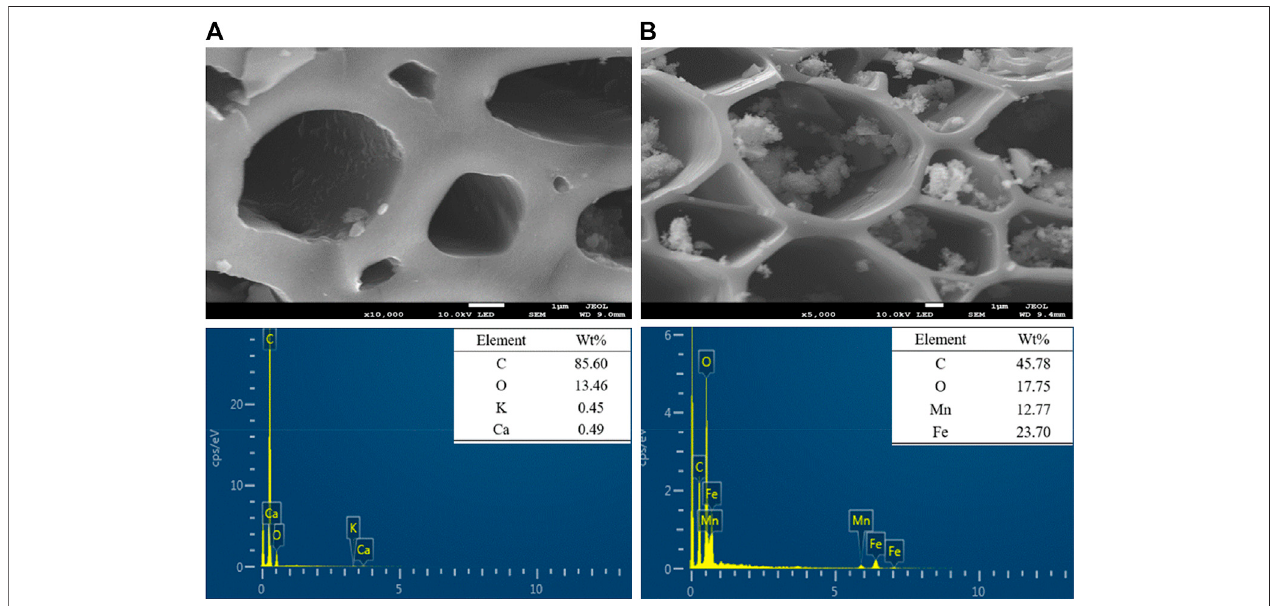
FIGURE 2 | Surface composition of MBC and MBC-MFC by SEM-EDS analysis. (A) MBC; (B) MBC-MFC.